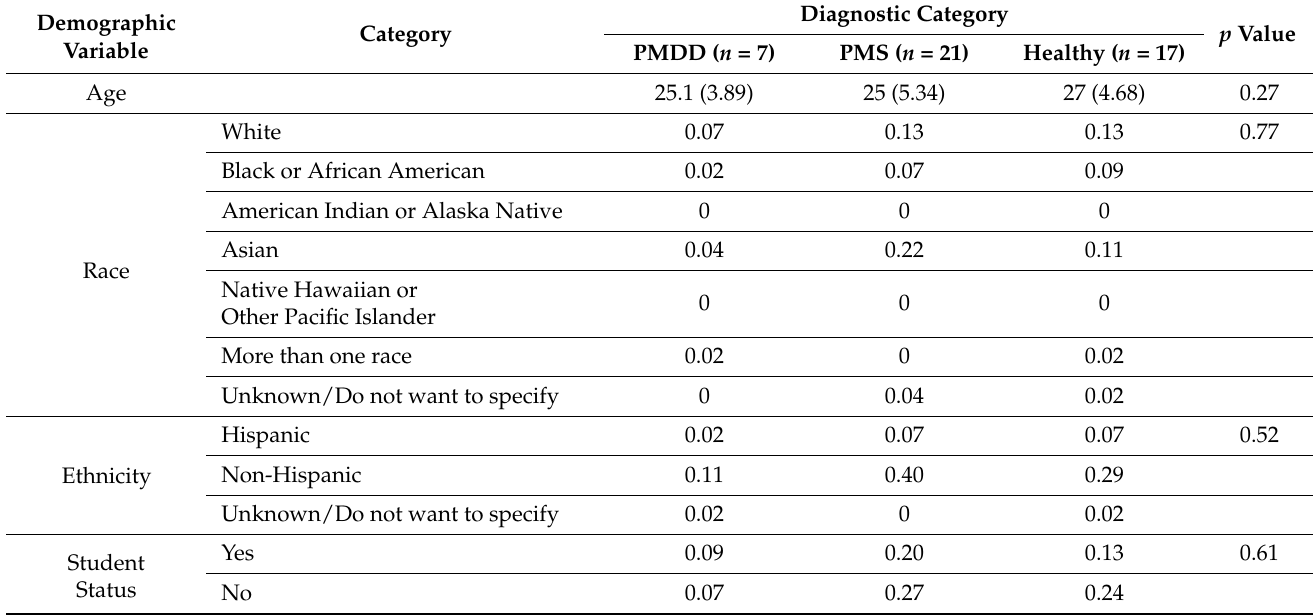
Table A2. Demographic characteristics according to